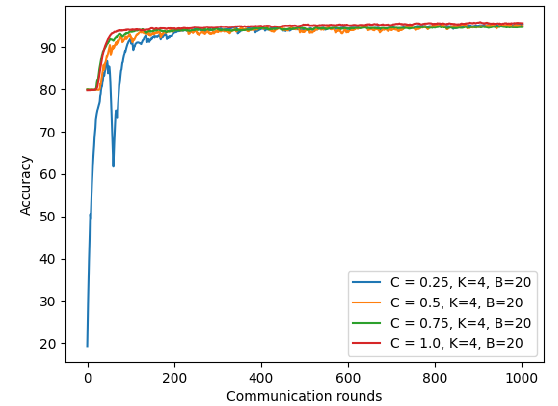
Figure 15. Non-IID with different client-fraction based on symptom